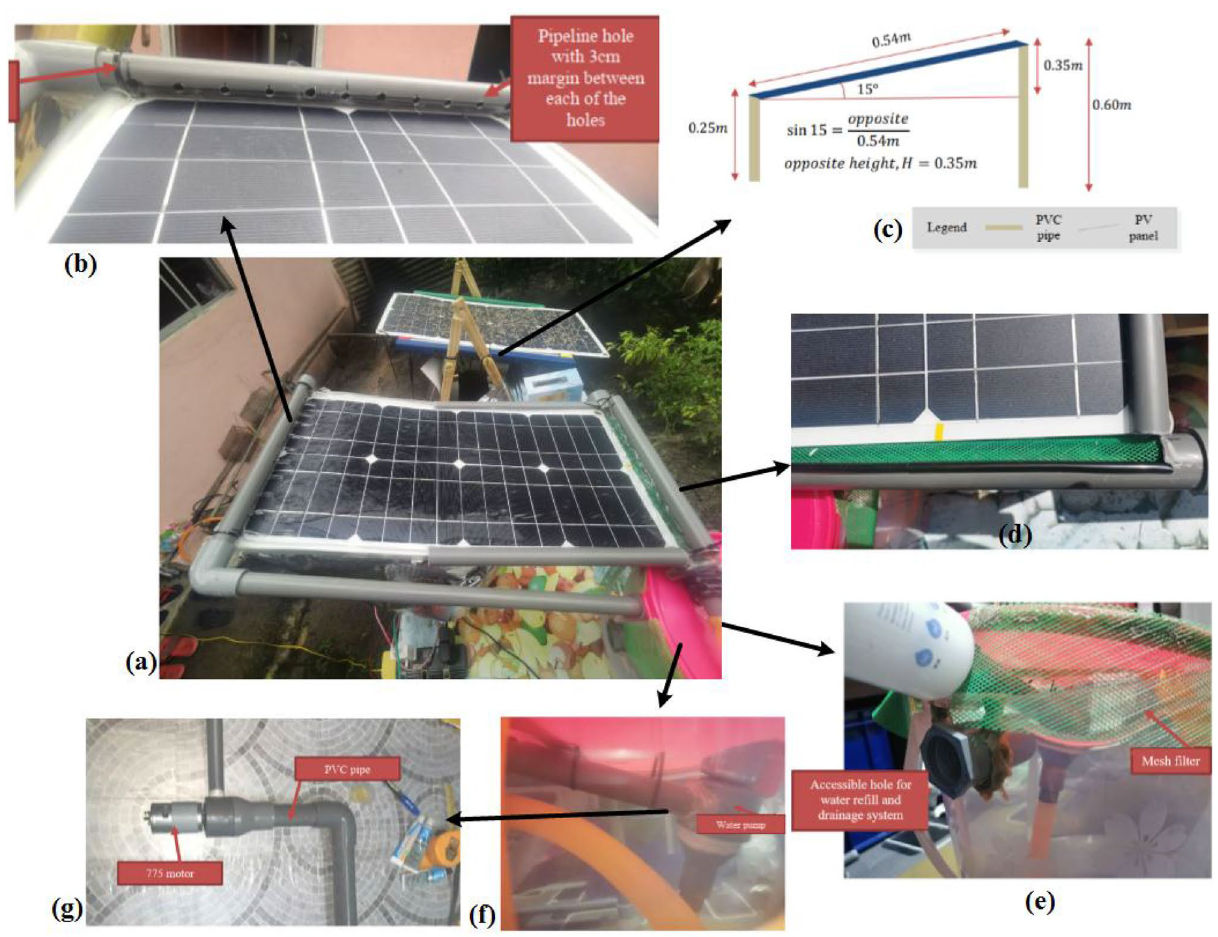
onometric analysis for PV-stand design, both 10 W mono modules were installed at 15 o tilt angle facing to the north. ( d ) Mesh gut- ter to filter large debris after the water drains off cleaning. ( e ) Fil- ter to purify the water before it is back to the tank. ( f ) 775 motor is installed as submerged in water. ( g ) Installation of motor coalesced PVC pipe